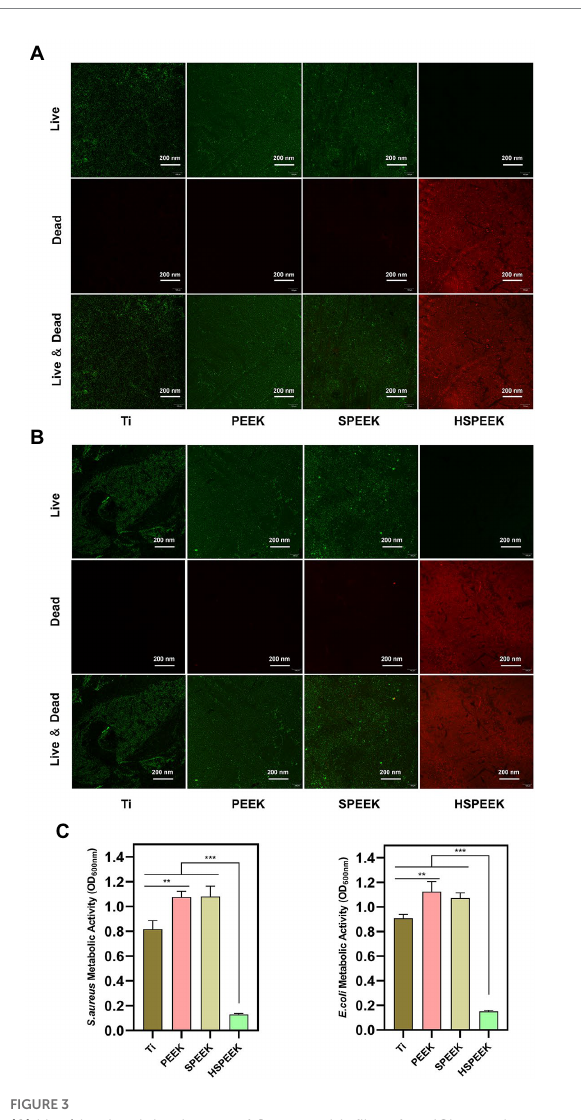
FIGURE 3 (A) Live/dead staining image of S. aureus biofilm after 48 h coculture with Ti, PEEK, SPEEK and HSPEEK, (B) Live/dead staining image of E. coli biofilm after 48 h coculture with Ti, PEEK, SPEEK and HSPEEK, and (C) Metabolic activity of S. aureus and E. coli biofilms after 48 h coculture on the surface of samples from each group. ( n = 3, ** p < 0.01, *** p < 0.001).